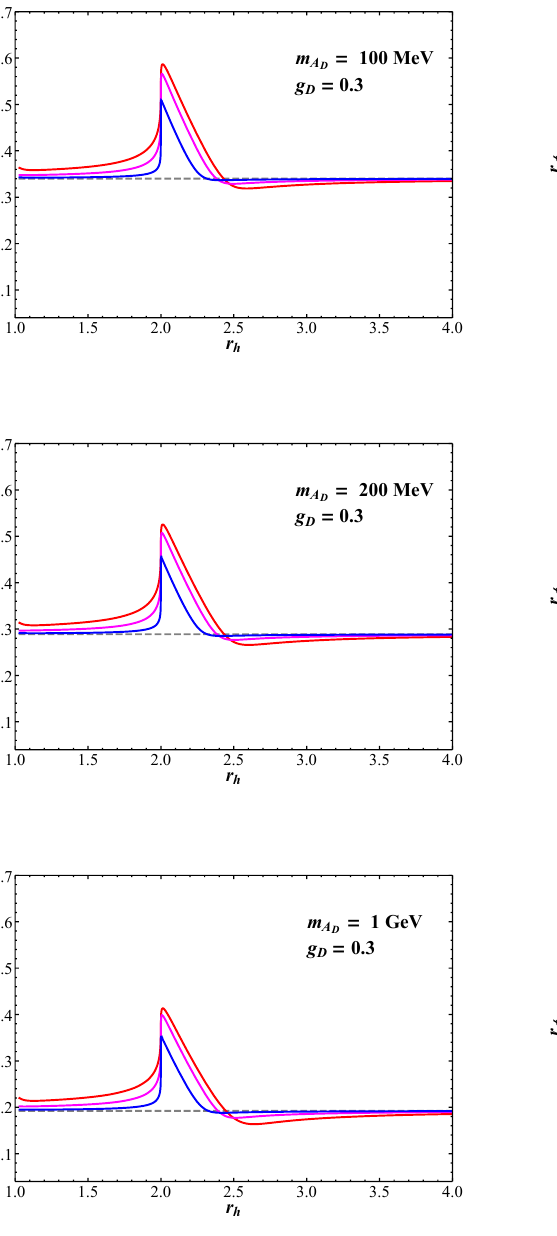
Figure 8. (Left) Contours in the r h - r φ plane that recreate the relic density assuming g D = 0 . 3 and various values of m A . The contours are depicted for b = 1 (Red), b = 0 . 4 (Magenta), b = 0 . 1 D (Blue), and b = 0 (Gray, dashed). (Right) Contours in the r h - r φ plane that recreate the relic density assuming b = 1 and various values of m A . The contours are depicted for g D = 1 (Orange), g D = 0 . 7 D (Red), g D = 0 . 5 (Magenta), g D = 0 . 3 (Blue), and g D = 0 . 1 (Green). The discontinuity in the g D = 1 line in the m A = 100 MeV chart emerges because, for this dark photon mass and dark coupling, D the observed DM relic abundance cannot be recreated with any 1 < r φ < 2 when 1 . 9 . r h . 2 . 2